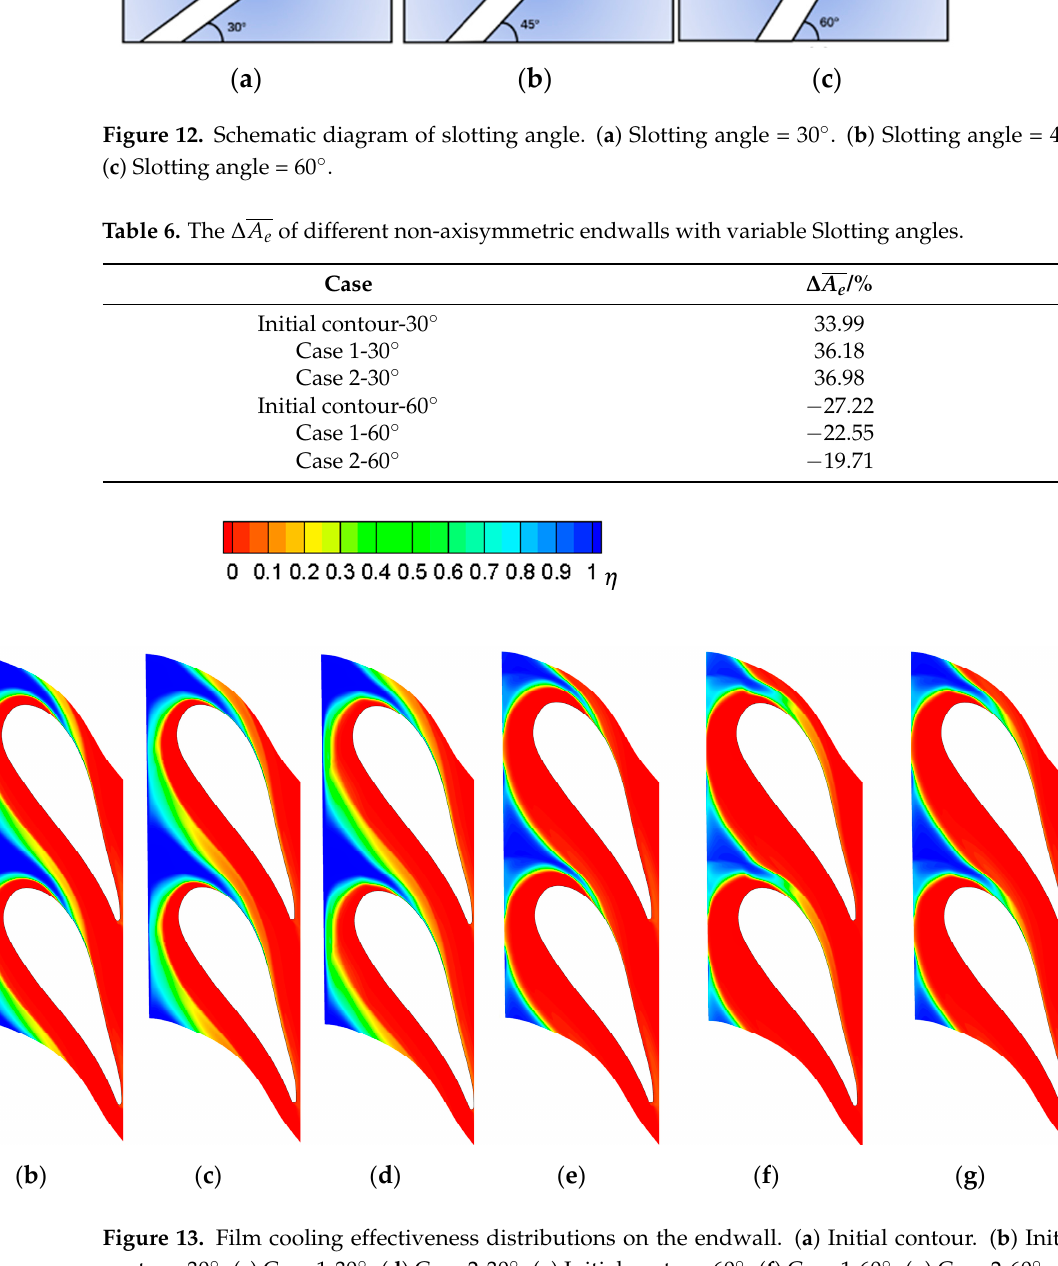
Figure 14. Axial distributions of laterally averaged film effectiveness on the endwall. 4. Conclusions